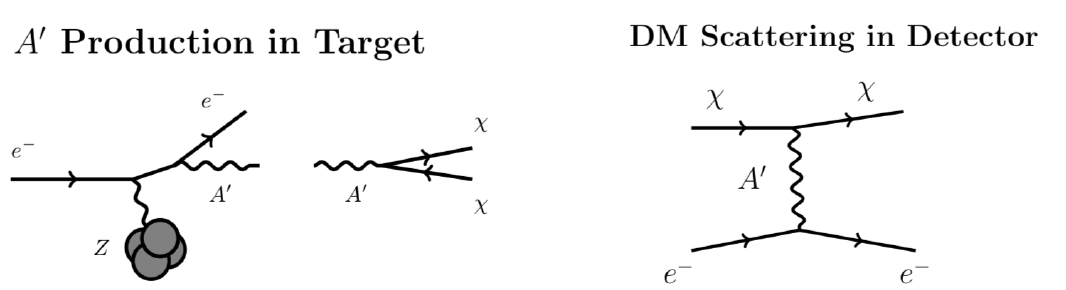
Figure 1. ( Left ). production of Dark Photons through a Bremsstrahlung-like radiative process and decay of A (cid:48) into a pair of DM particles; ( Right ) the χ -e − scattering is also mediated by A (cid:48)